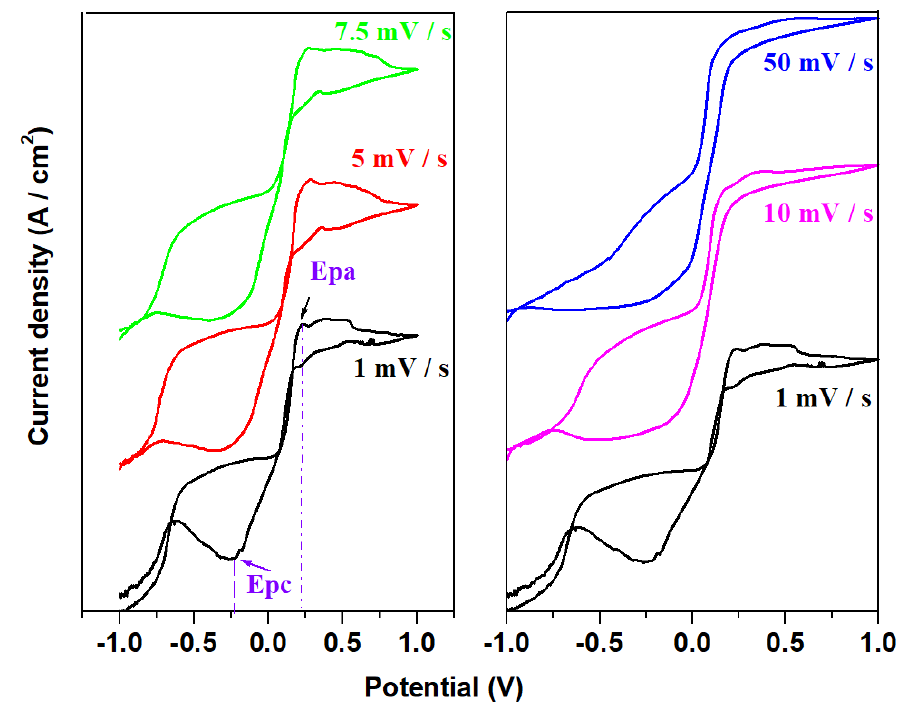
Figure 7. Cyclic voltammogram of the sample with 70 mol% NaH 2 PO 4 at different scan rates (from 1 mV/s to 50 mV/s).